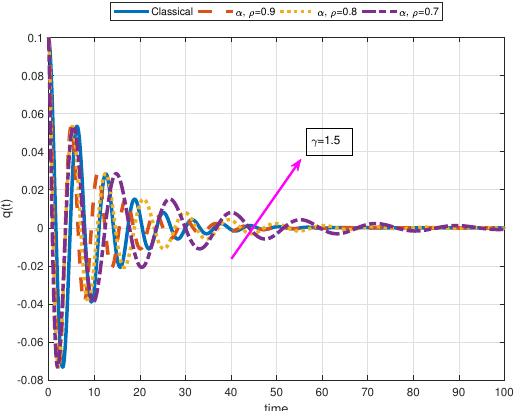
Figure 16. This plot is for the function q ( t ) with respect to the exponential source for some values of α and ρ when γ = 1.5, e 0 = 5 V, L = 10 H, C = 0.1 F, R = 2 Ω , q ( 0 ) = 10, and M D α , ρ , γ q ( 0 ) =